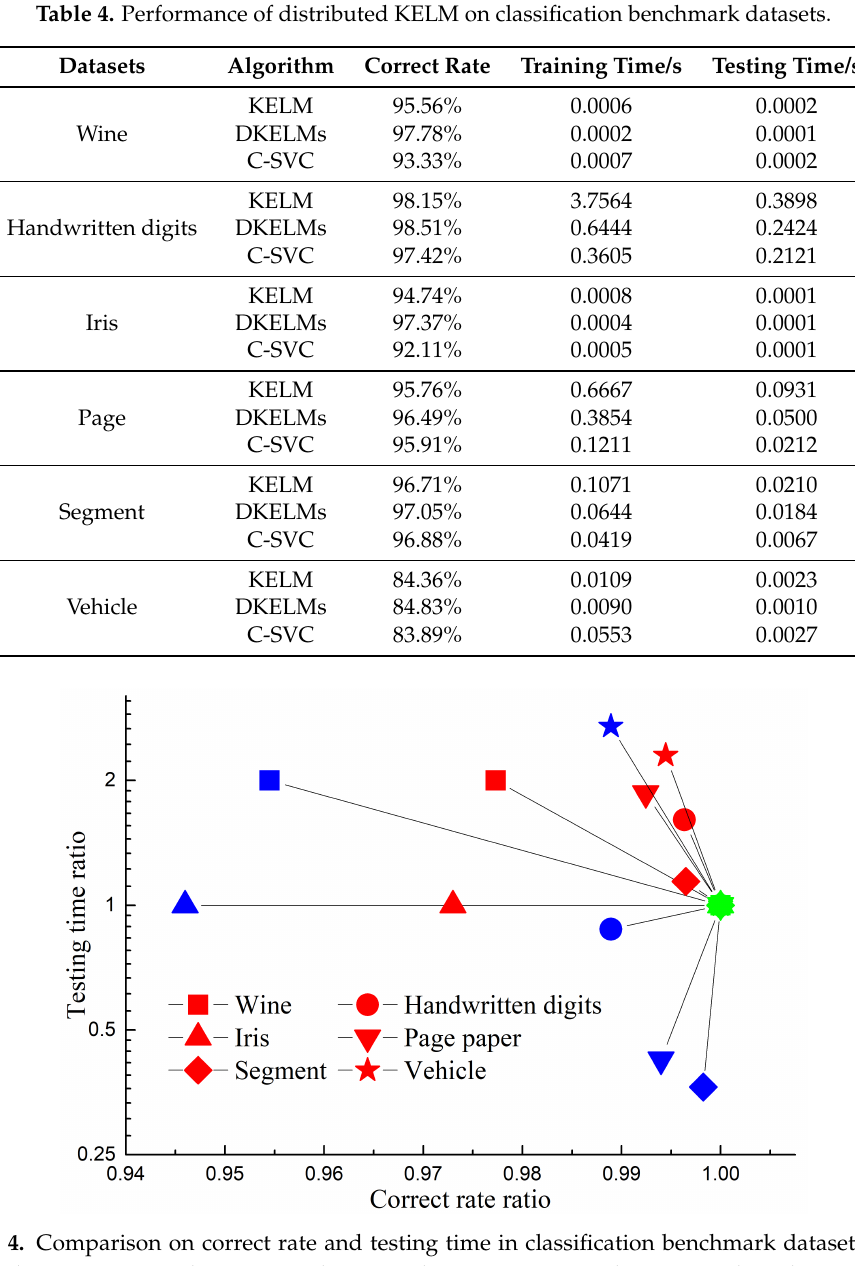
Figure 4. Comparison on correct rate and testing time in classification benchmark datasets. (Red, blue and green respectively represent the original KELM, C-SVC and DKELMs algorithms. Different legend shapes represent different